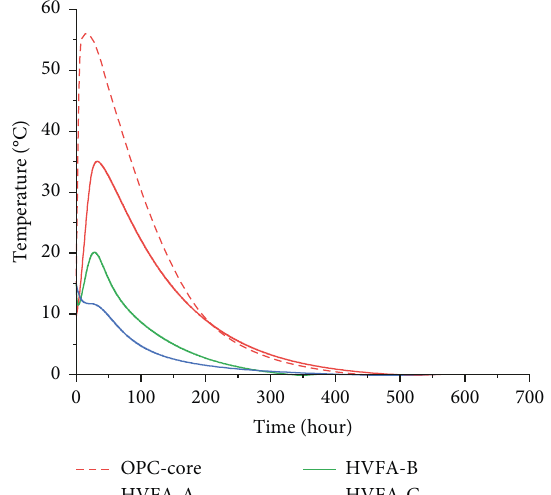
Figure 7: Temperature development in OPC and HVFA concrete.